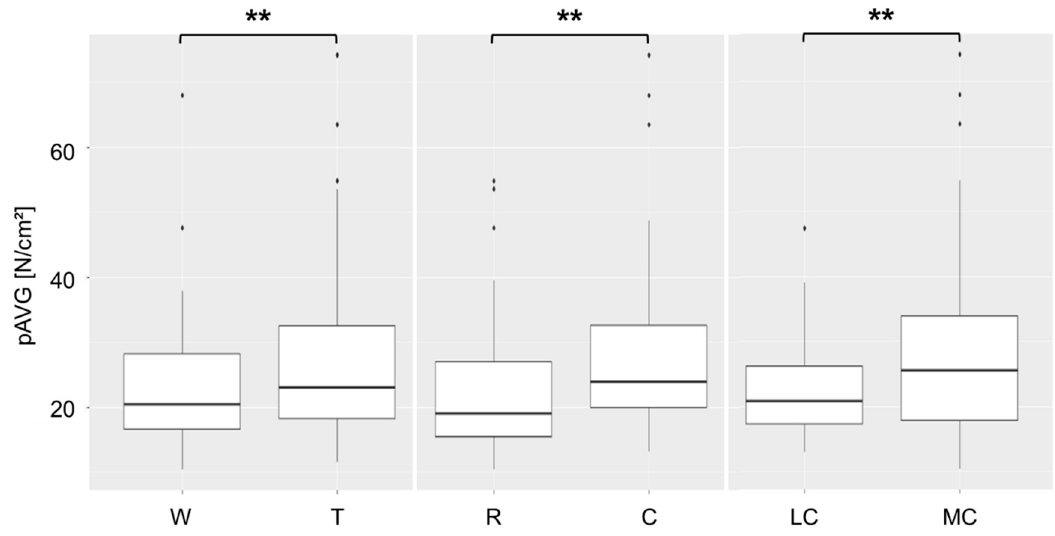
Figure 4. Influence of the factors gait (W = walk, T = trot), flooring (R = rubber mats, C = concrete) and claw (LC = lateral claw, MC = medial claw) on the average pressure (pAVG); the mean values of subsequences with 3 to 8 consecutive steps from ten dairy cows are plotted. ** indicates a significant influence of the different factors, p -value < 0.001.